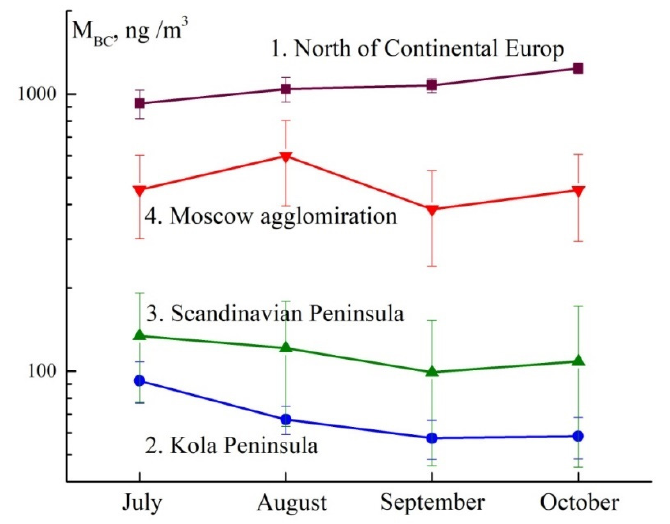
Figure 10. Variability of monthly average concentrations of black carbon in four continental regions (MERRA-2 reanalysis data).